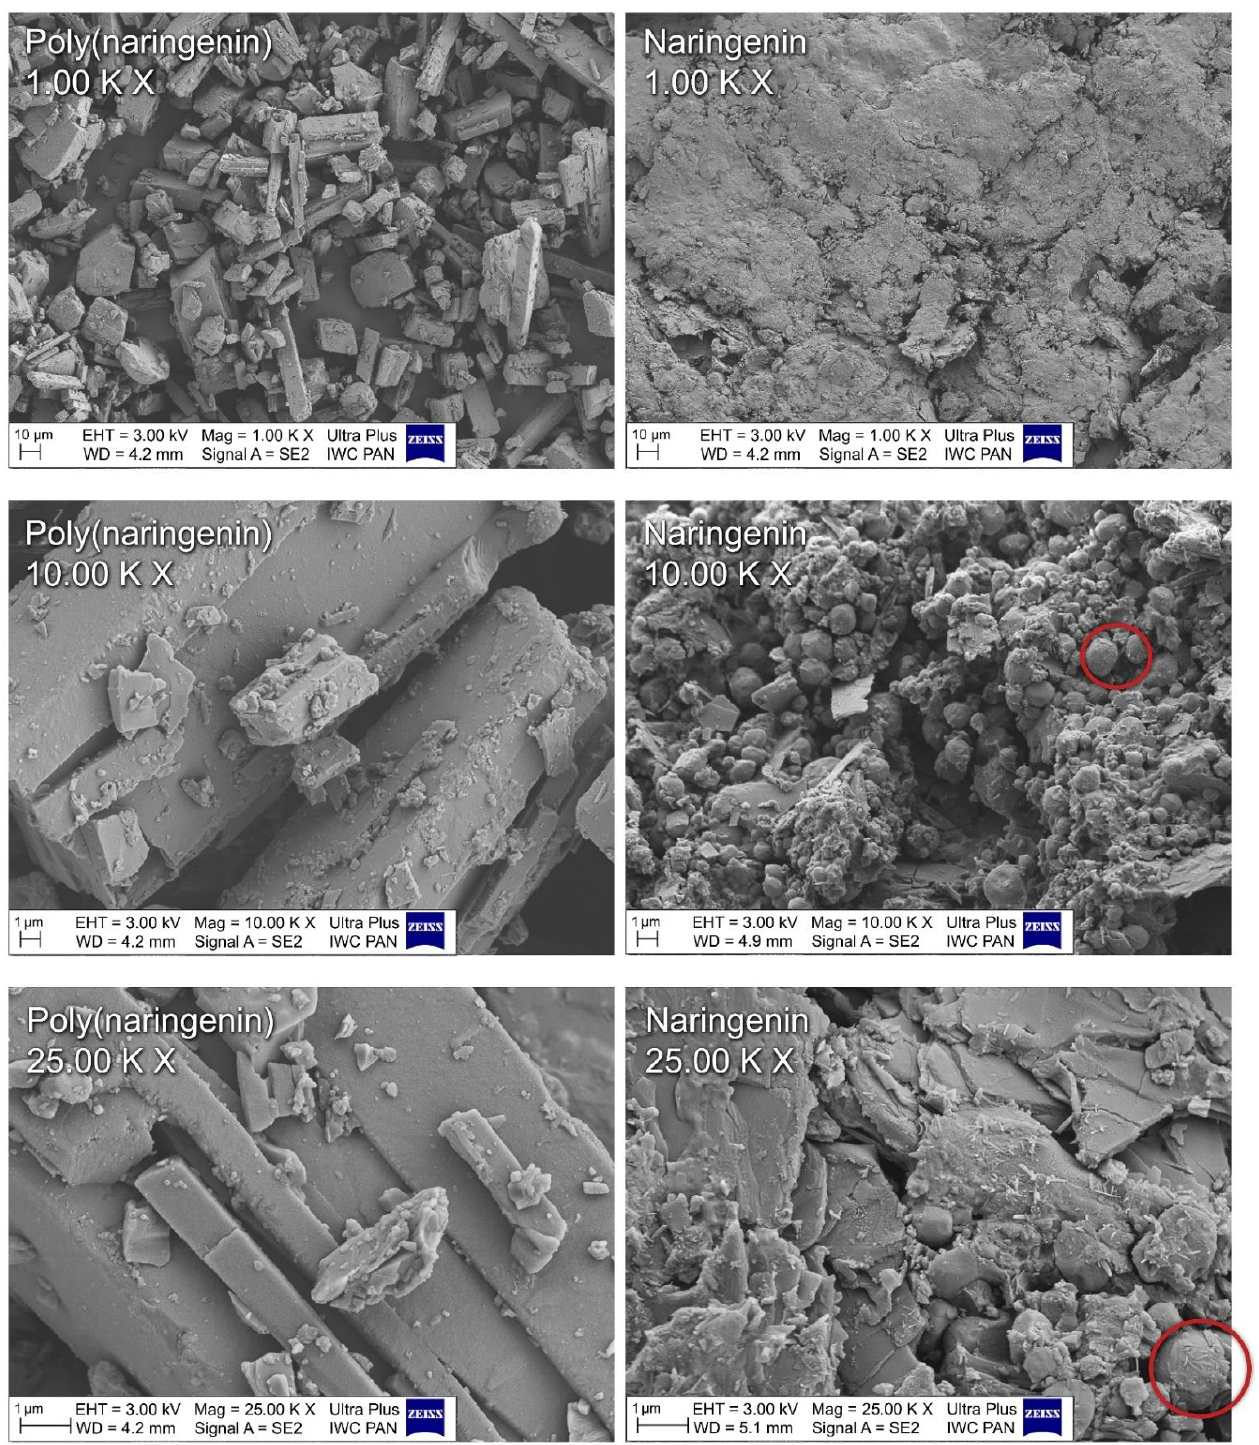
Figure 4. SEM images of naringenin and poly(naringenin) at 1.00 K×, 10.00 K× and 25.00 K× magnification. Red circles: ball-shaped structures.